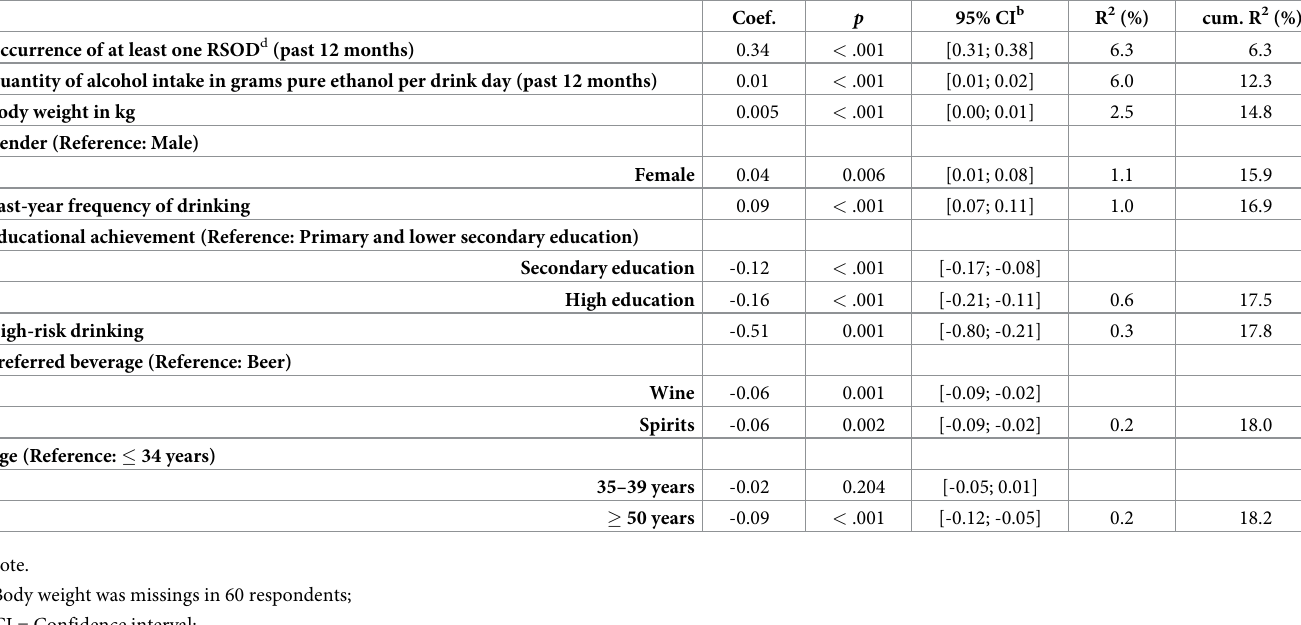
Table 2. Linear regression model and variance explanation of demographic and sociodemographic characteristics and drinking patterns for the difference between the subjective threshold of alcohol needed to perceive impairments and the gender-specific RSOD threshold value (40 grams of pure ethanol for women and 60 grams of pure ethanol for men; outcome), n = 4,544 a